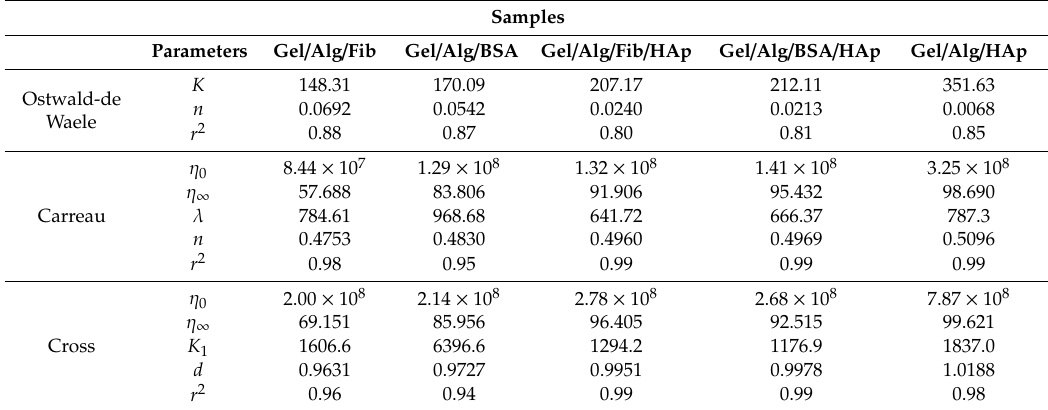
Table 1. Flow curve modeling.